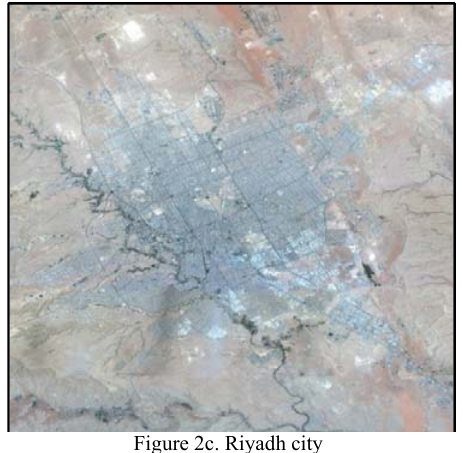
Figure 2c. Riyadh city (Satellite Sensor: GeoEye, GSD:50cm, Acquisition